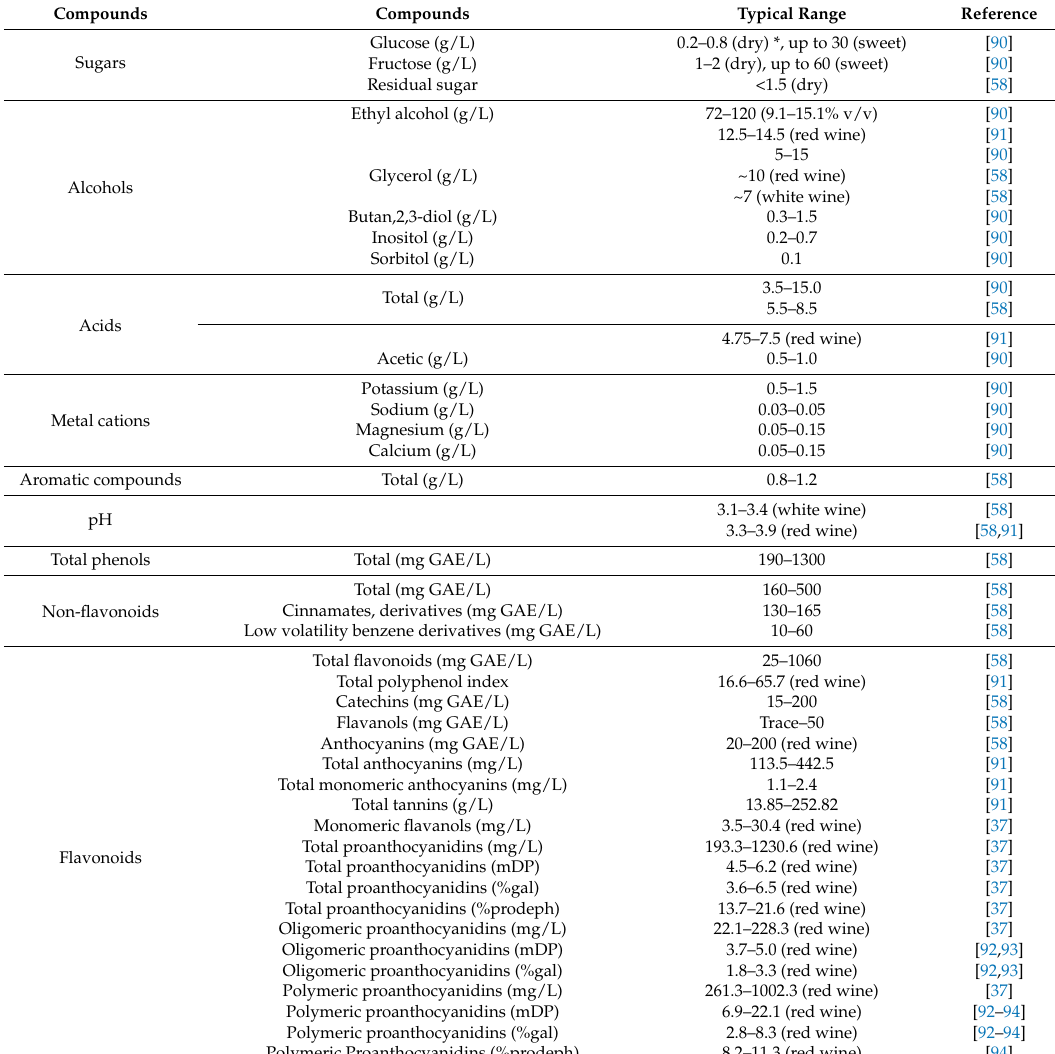
Table 3. Main chemical compounds in white and red